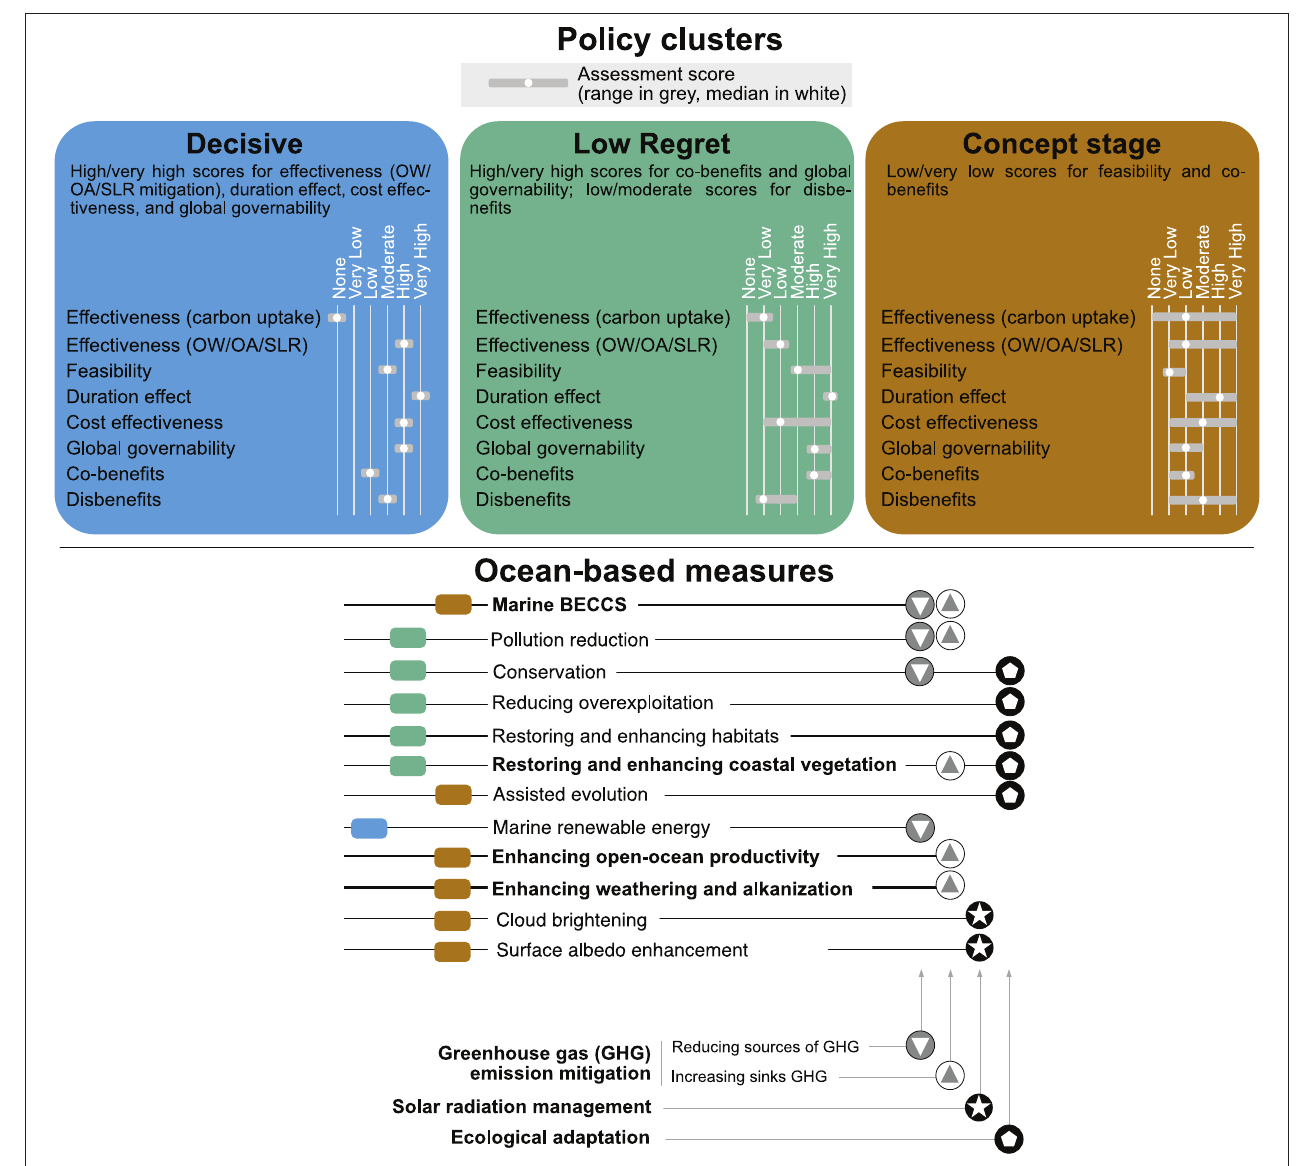
FIGURE 2 | Policy clusters of ocean-based climate action. The measures in bold are the four NETs given detailed attention in this paper, others are modified from Gattuso et al.